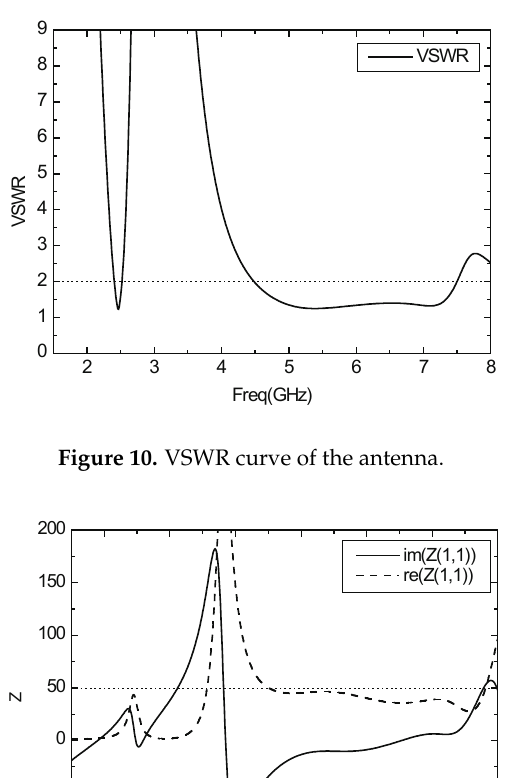
Figure 9. Parameter S 11 of the antenna.